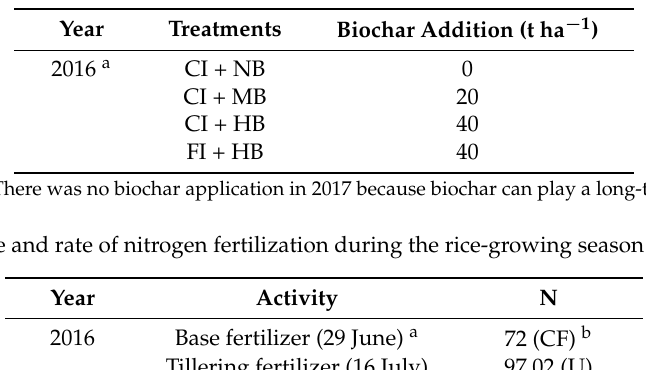
Table 1. Biochar application in different treatments (t ha − 1 ).